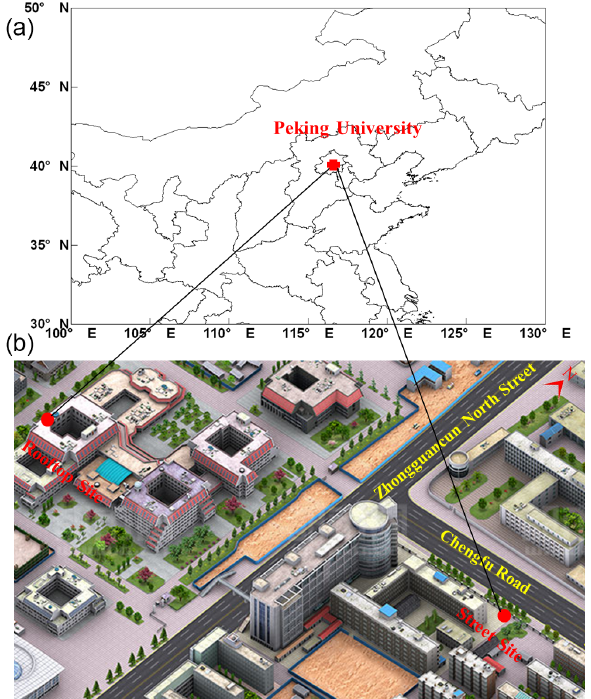
Figure 1. The location of sampling sites (a) and 3-D view of the two sampling sites ( b , download from